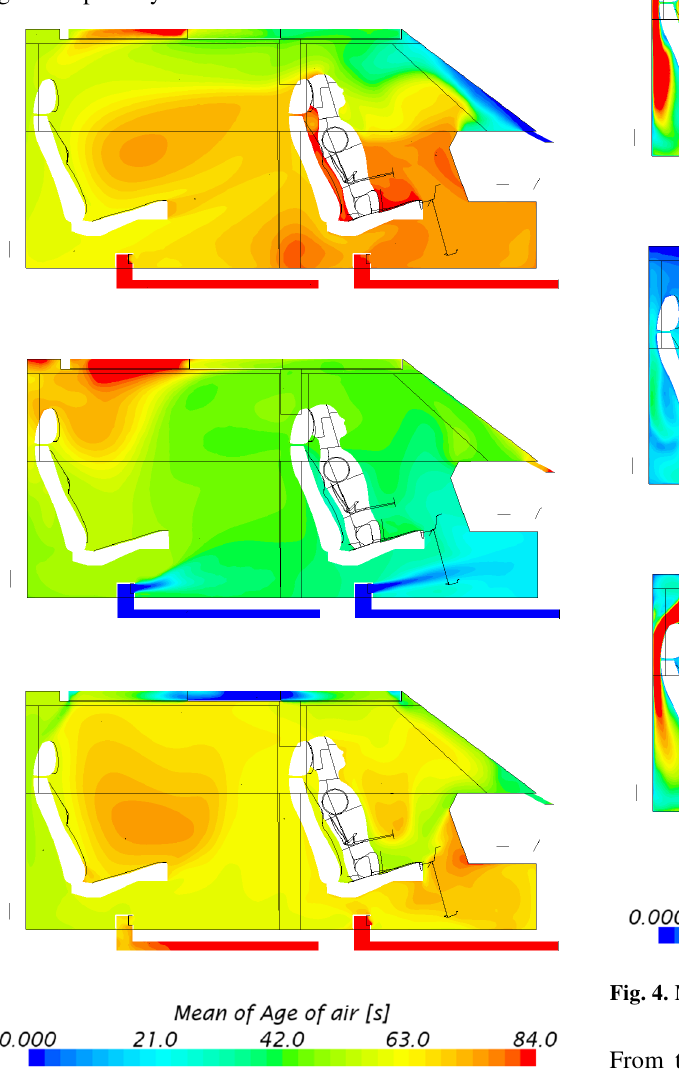
Fig. 3 . Mean of Age of air (MV,FV,CV) .